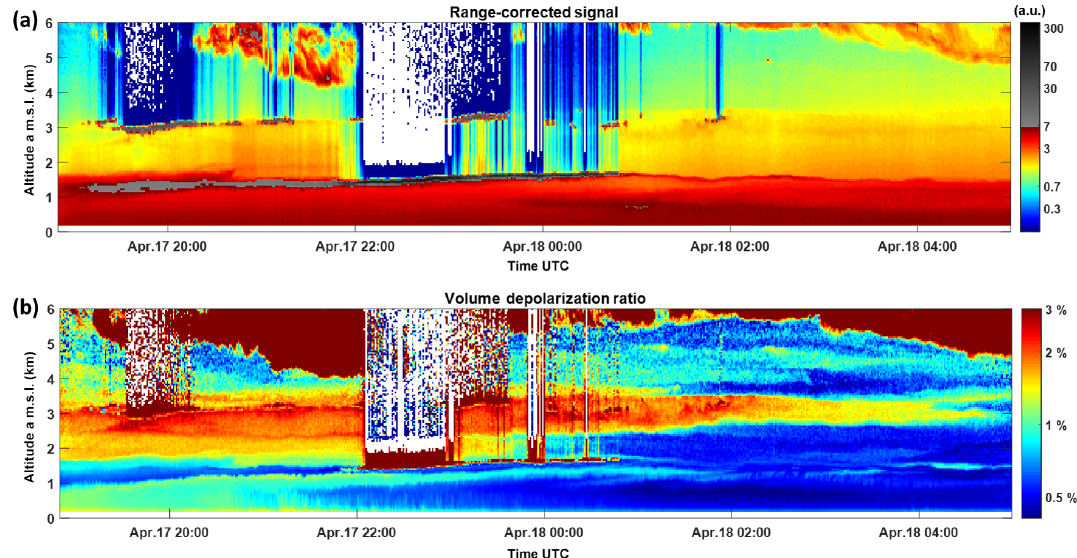
Figure 3. Time series, from 17 April 2015 at 18:50UTC to 18 April 2015 at 05:00UTC, of the profiles of (a) elastic range-corrected signal ) and (b) volume depolarization ratio ( S λ E